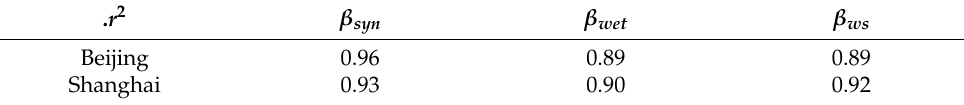
Figure 8. FiJing degree of , , and in Beijing ( a ) and Shanghai ( b ). Figure 8. Fitting degree of β syn , β wet , and β ws in Beijing ( a ) and Shanghai ( b ). (cid:16) (cid:11)X3 (cid:16) (cid:13)dc (cid:16) (cid:13)(cid:11) Table 6. values for Beijing and Shanghai , O Table 6. r 2 values for Beijing and